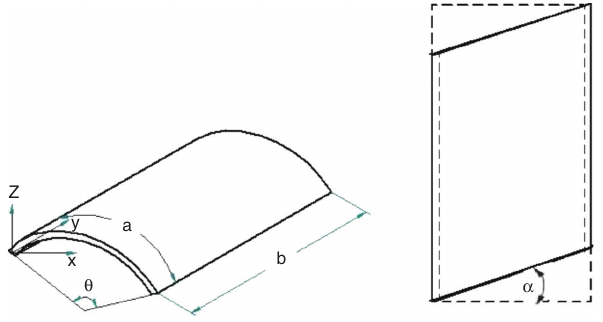
Figure 1 Geometry of the cylindrical skew panels with dimensions.